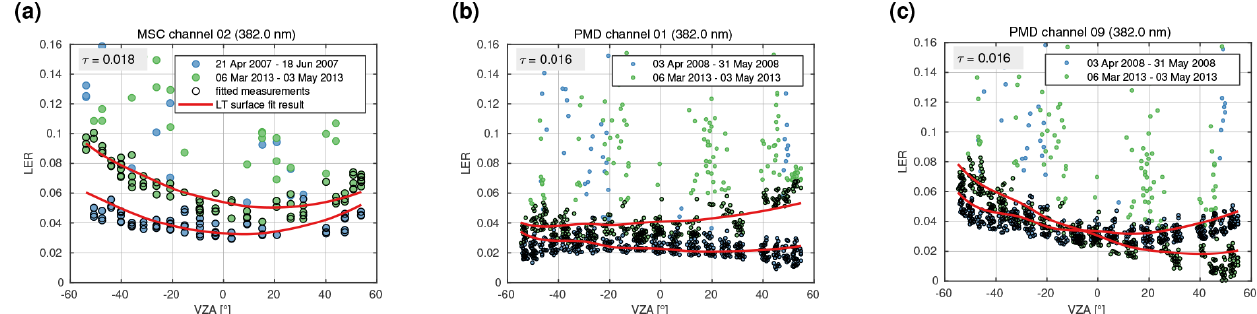
Figure 10. Detailed fit results from surface of three GOME-2 bands measured over Australia (cf. Fig. 8a), comparing the fit results with measurements selected from the beginning (blue dots) and the end (green dots): (a) MSC channel 2, the fit results (red lines) correspond to Fig. 8f, (b) for PMD-PP, and (c) for PMD-SP. Note the significant differences between the residual VZA dependence and the trends of three GOME-2 bands measuring at the same wavelength of 382nm. Note that reflectance measurements below the red line will later result in negative CFs.